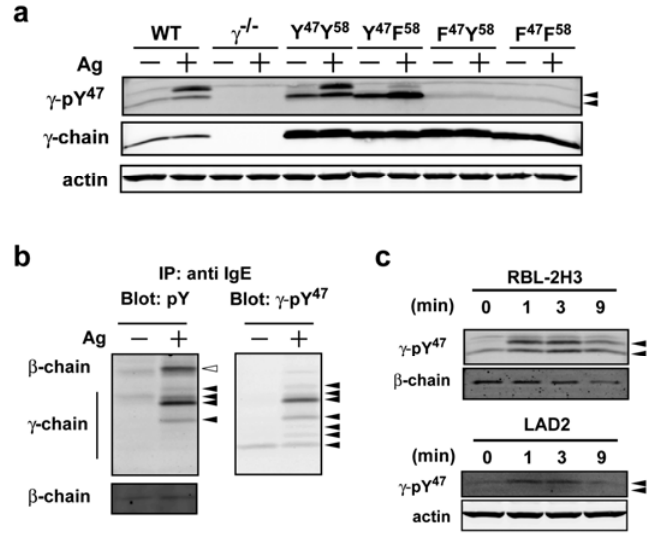
Figure 1. A novel phospho-specific antibody ( γ -pY 47 ) that selectively recognizes the phosphorylated Fc ε RI γ ITAM Y 47 from mouse, rat, and human origin. ( a ) Murine WT BMMCs or γ − / − BMMCs retrovirally transduced with Fc ε RI γ mutants ( YY , YF , FY , and FF ) or control vector ( γ − / − ) were sensitized with IgE and stimulated with Ag for 1 min at 37 °C. Whole cell lysates were resolved by SDS-PAGE and immunoblotted with γ -pY 47 antibody under reducing conditions. ( b ) Fc ε RI was immunoprecipitated from whole cell lysates of WT cells (see Experimental Section) and resolved by SDS-PAGE under non-reducing conditions. Immunoblots were analyzed with anti-phosphotyrosine antibody (4G10) or γ -pY 47 antibody. ( c ) Whole cell lysates from stimulated or non-stimulated rat (RBL-2H3) and human (LAD2) mast cell lines were probed for phosphorylation of Fc ε RI with γ -pY 47